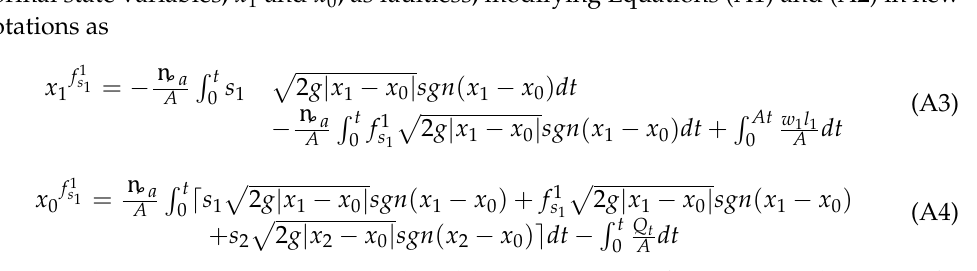
Figure 1. Three-pond hydraulic system.